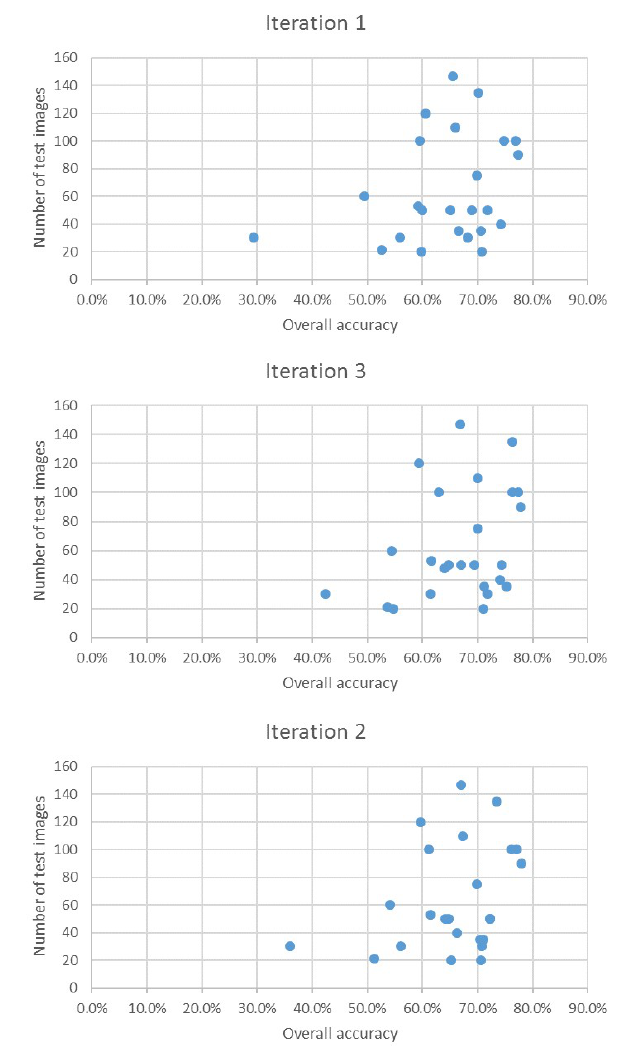
Figure 5. Number of test images versus overall